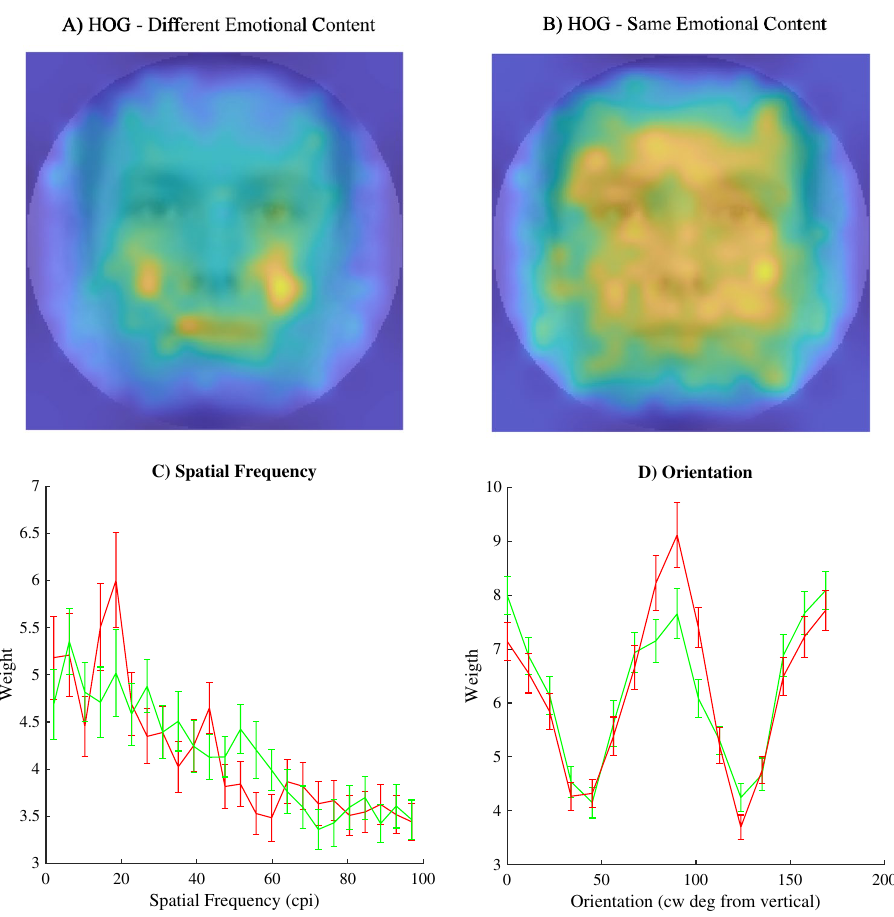
Figure 6. Visual representations of the most relevant features for decoding. ( A , B ) Heatmaps (generated using MATLAB 2016a) reflecting the relevance of spatial locations of the HOG features to decoding either trials with different emotional content ( A ) or the same emotional content ( B ) overlaid on the averages of all images with a neutral expression. As relative importance of a location increases, colour changes from blue through green to yellow. ( C ) Here we show the weight, reflecting the percentage of contribution to overall performance, for each band of spatial frequencies used to decode face selection for both trial types (red line, different emotional content; green line same emotional content). Errorbars reflect the standard error of the mean. ( D ) Here we show the weight for each band of oriented edges used to decode initial eye movements for both trial types (red line, different emotional content; green line same emotional content). Errorbars reflect the standard error of the mean. Note that, for both spatial frequency and orientation, the only clear difference is a larger weight for horizontal orientations in trials where the emotional content differs. Figures generated using Matlab 2019b (www. mathw orks. com).